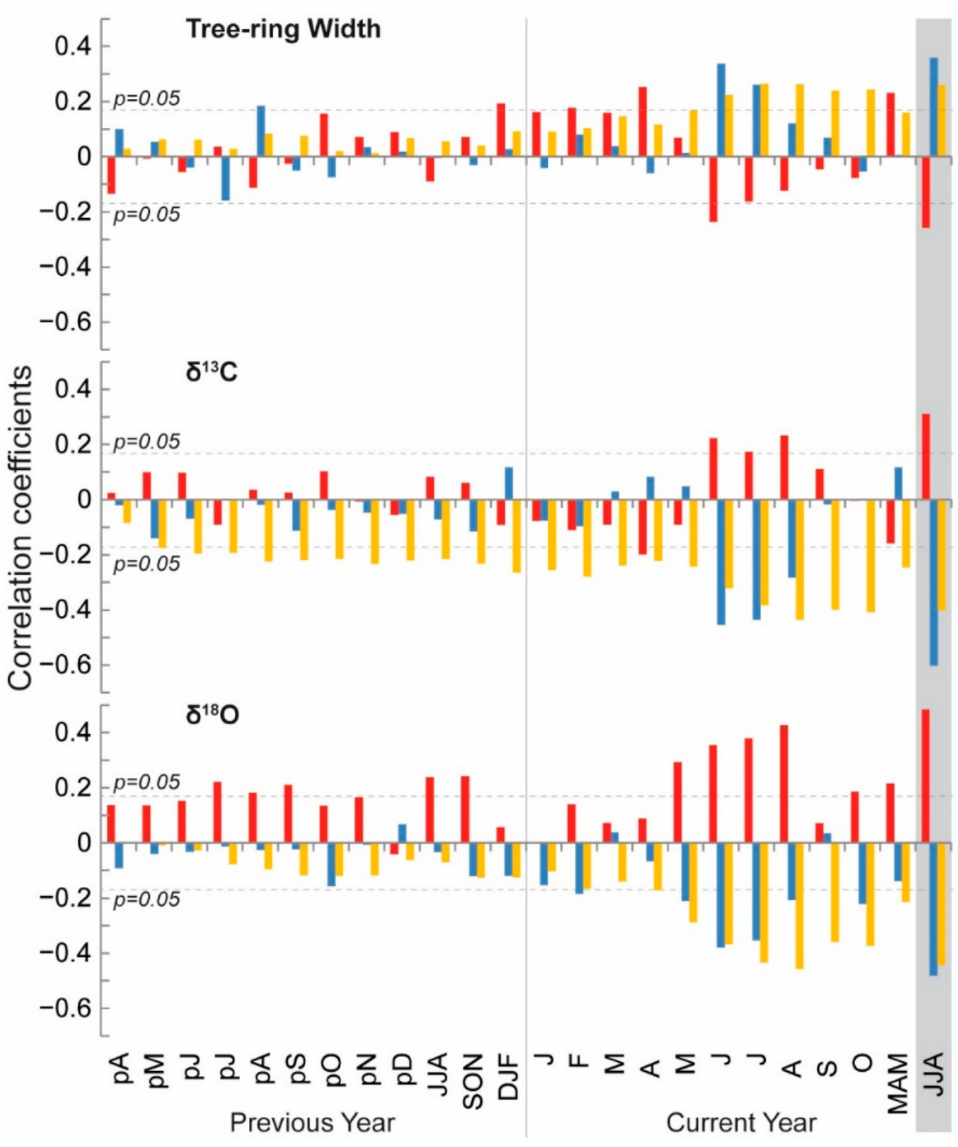
Figure 4. Pearson’s correlation coefficients between the TRW chronology and the two sets of isotope data with average temperature (red), Palmer drought severity index (PDSI) (yellow), and precipitation sums (blue) for the period of 1901–2018. The correlations are presented from April of the previous year (pA) to October of the current year (O); associated seasonal means are also shown. The grey vertical shadings indicate the summer (JJA) period of maximum response. Monthly gridded data (0.5 × 0.5 ◦ grid) from the CRU TS3.24.01 database were used to calculate the correlations. The δ 13 C isotopic signal shows a significant positive correlation with temperature in June ( r = 0.22) and August ( r = 0.23) of the current year, and an even stronger negative correlation with precipitation during the summer months, particularly June ( r = − 0.45). For precipitation, the highest correlation is found when the whole summer period (JJA) is included ( r = 0.60). Regarding the PDSI index, almost all months of both previous